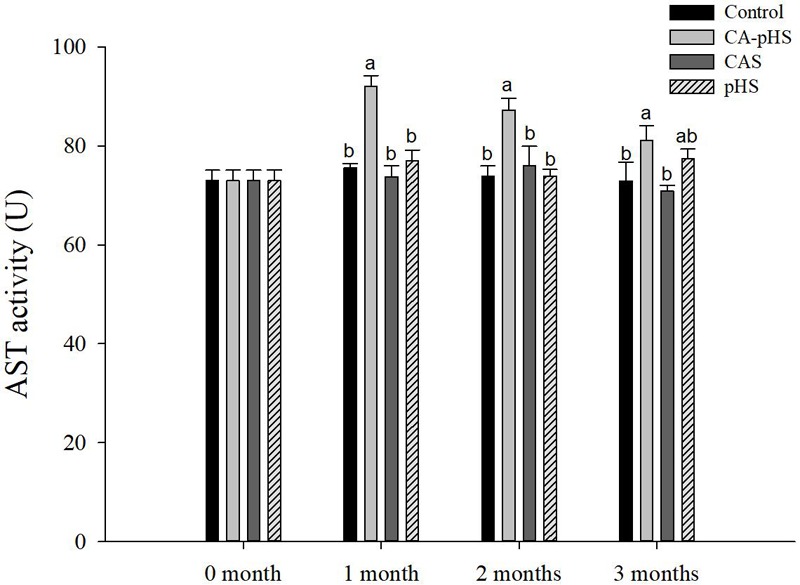
Juvenile of S. constricta aspartate aminotransferase (AST) activity levels in the long-term toxicity test. Bars (mean ± SE, n = 3) with different letters denote significant differences (p < 0.05) among the four groups in each month. The letters “ns” indicate insignificant difference among the four groups in each month.